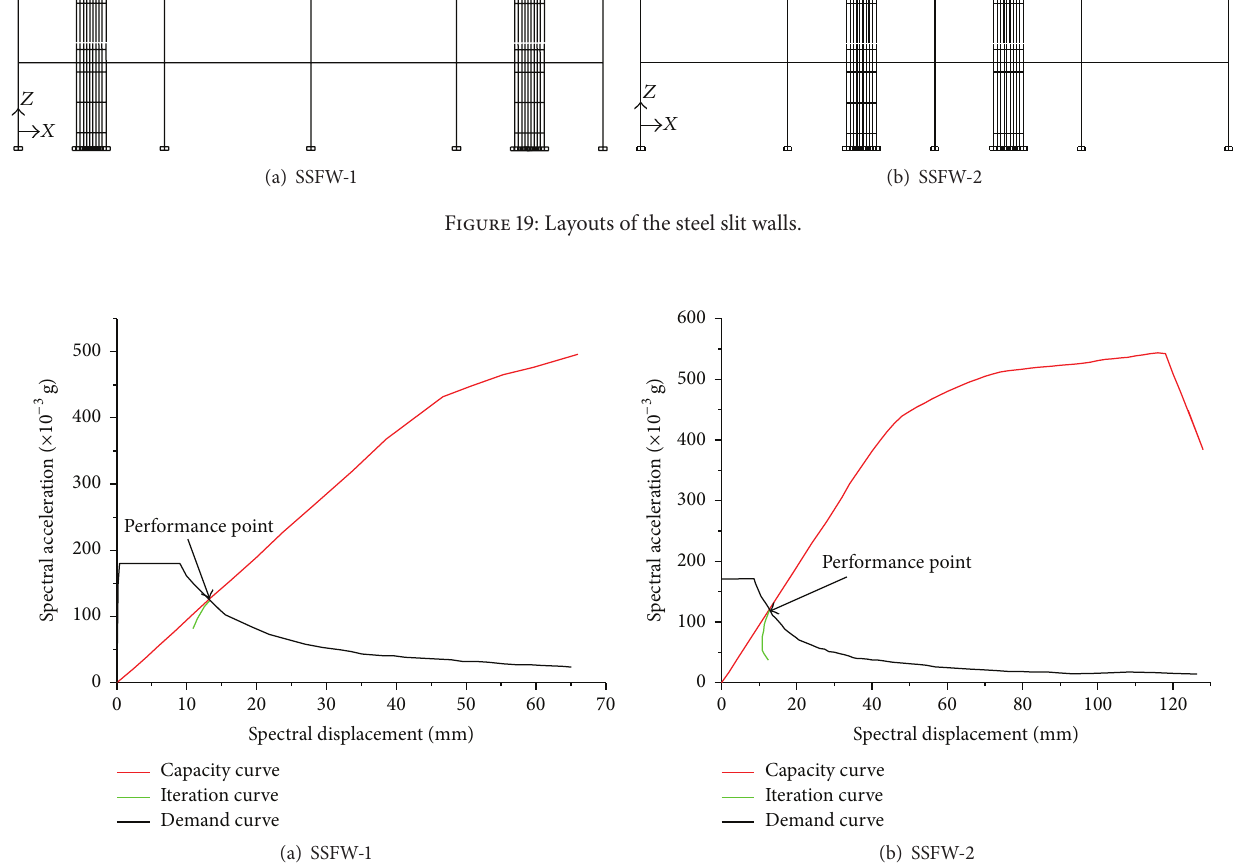
Figure 20: Performance point of the different structure under frequent earthquake